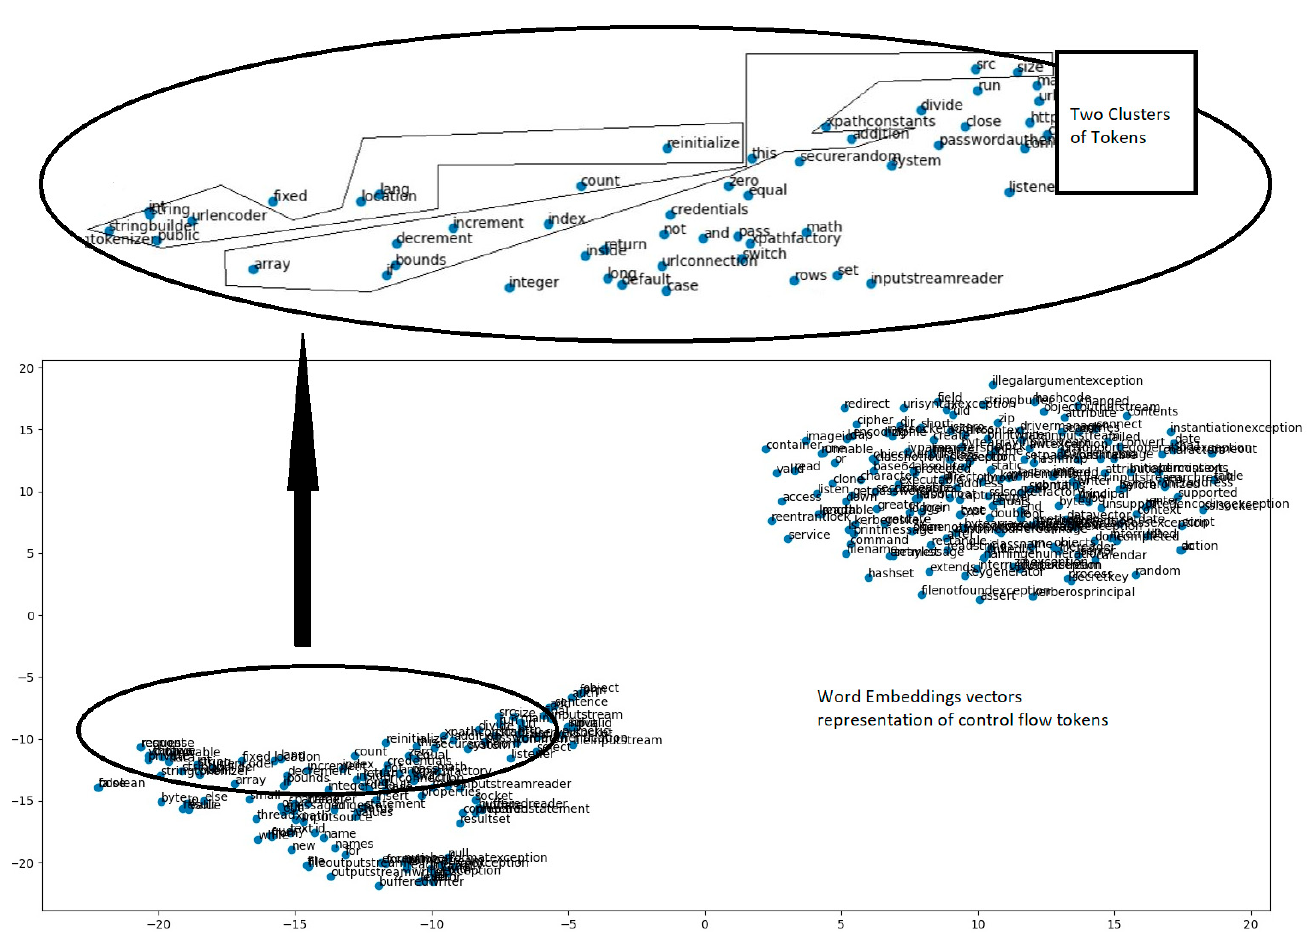
Figure 2. Control flow tokens clusters.